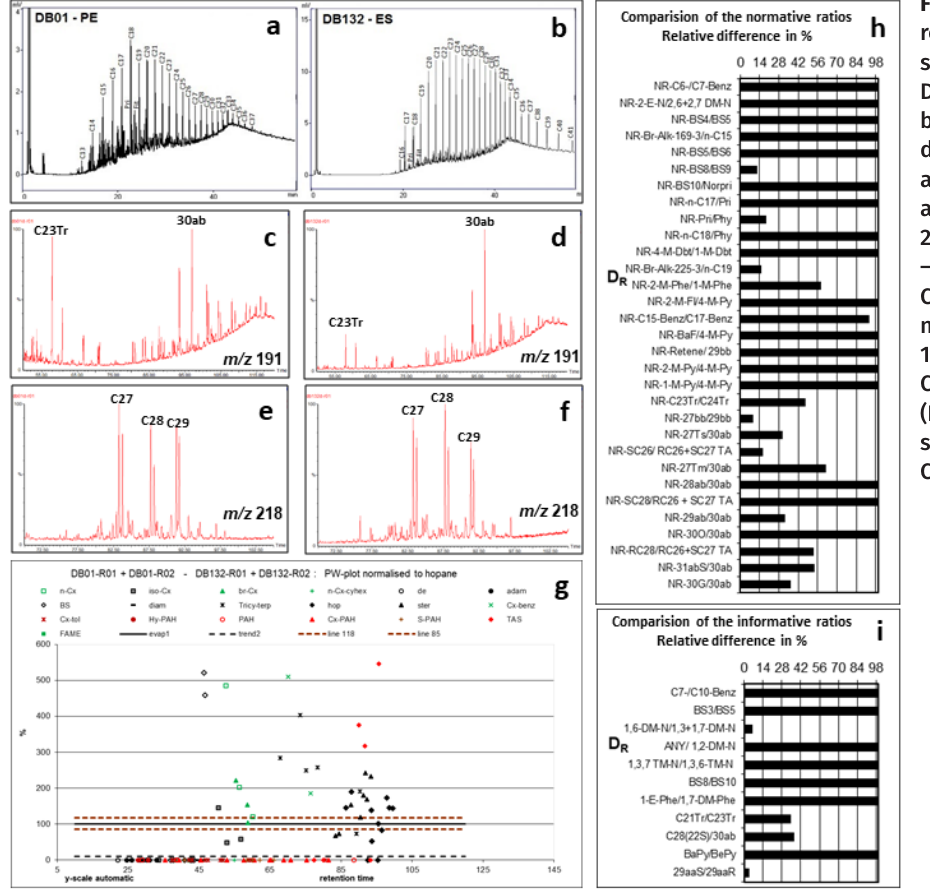
Figure 6. Combined results between samples DB01 and DB132, indicating that both samples are from different sources